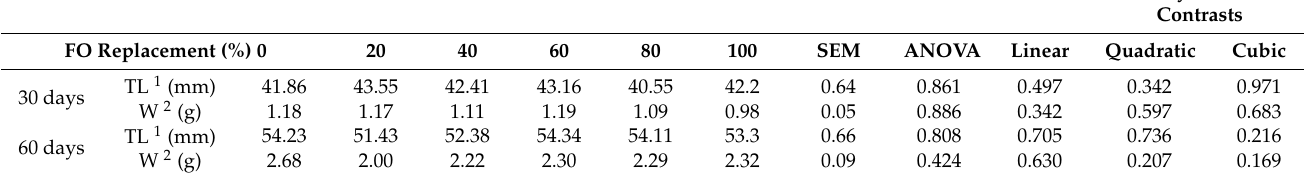
Values are mean ± standard deviation (SD). Some minor fatty acids (<0.05%) are not shown. 1 Total saturated fatty acids 2 Total monounsaturated fatty acids 3 Total polyunsaturated fatty acids 4 Linolenic acid/linoeic acid. Means in the same row with different superscripts are significantly different ( p < 0.05). Table 4. Growth performance of juvenile tench fed practical diets with different replacements of cod liver oil (FO) with camelina oil (CO) over 30 and 60 days.